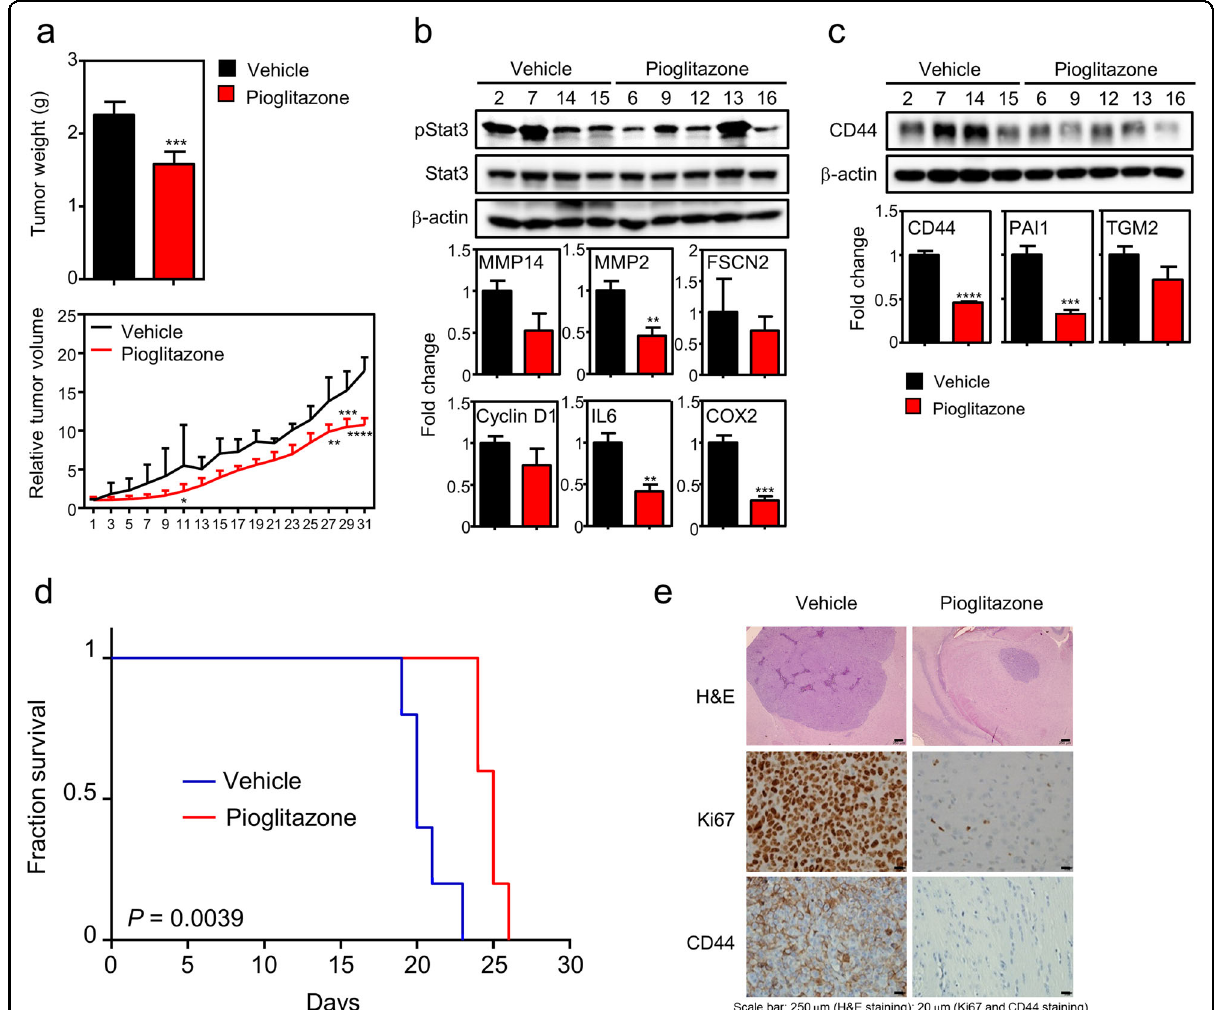
Fig. 4 PPAR γ is a therapeutic target for MES GBM. a In vivo analysis of xenograft tumors with pioglitazone treatment. Five millions of MES 83 GSCs were injected into the fl ank region of athymic nude mice. When tumors were visible, mice were intraperitoneally administered vehicle ( n = 4) or 100 mg/kg pioglitazone ( n = 5) every other day for 31 days. Both tumor weight (upper) and volume (lower) were measured every other day or at the end of the experiment, respectively. Tumor growth is represented as the relative mean tumor size ± SEM. Asterisks are references as follows: ** P < 0.01, *** P < 0.001, and **** P < 0.0001 (Student ’ s t test (upper) and two-way ANOVA, Sidak ’ s post hoc test (lower)). b , c Gene-expression analysis in individual tumor samples upon pioglitazone treatment. Genes involved in STAT3 signaling (left) or MES markers (right) were assayed in the residual tumor tissues at the end of the in vivo experiment. d Survival analysis of the orthotopic mouse model. Orthotopic xenograft tumors were established by intracranial injection of one thousand 83 cells, followed by survival analysis. Kaplan – Meier plots are presented to show the survival of mice